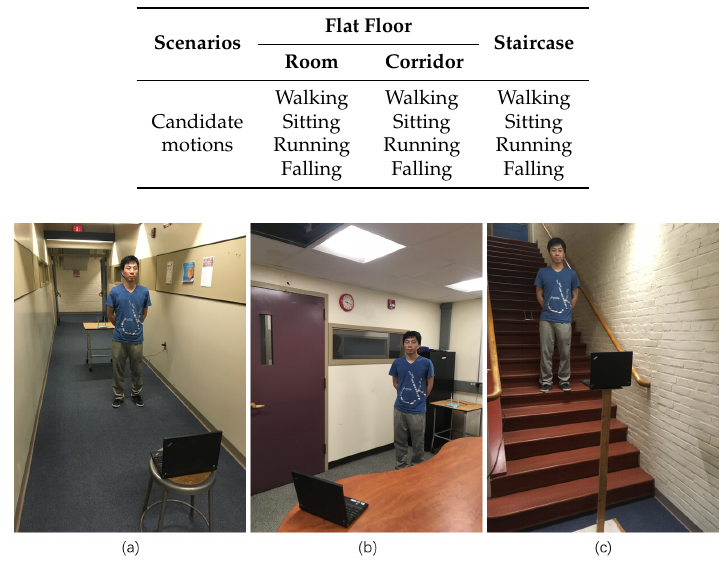
Figure 8. Experimental environments: ( a ) corridor; ( b ) room; ( c )